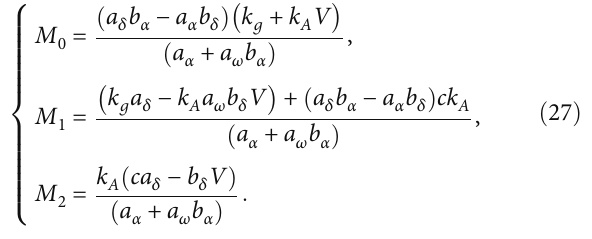
Table 5: Pole assignment results at the feature points. Feature point